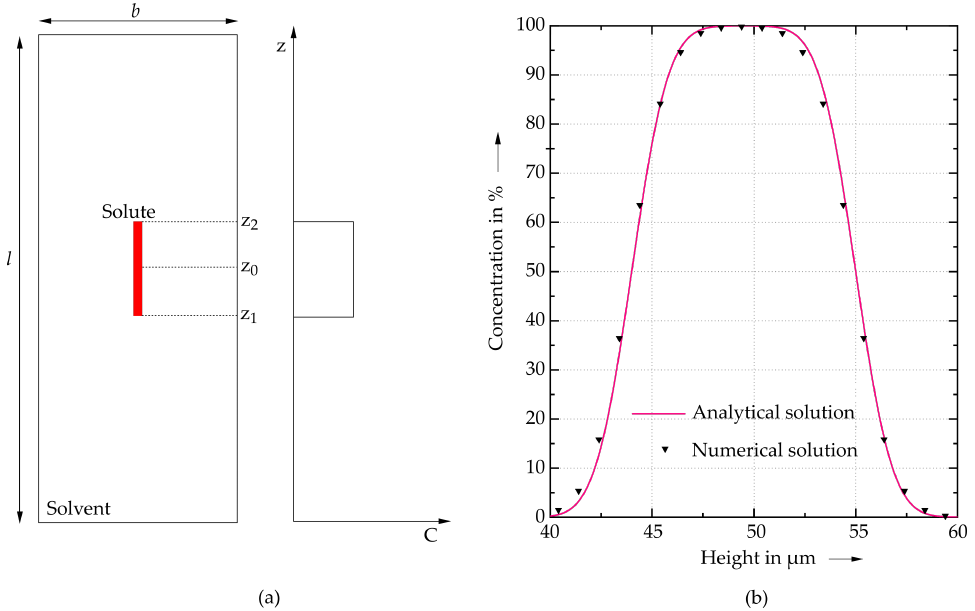
Figure 1. The verification case ( a ) and the comparison of the analytical solution with the numerical solution for t = 1.0 s ( b ). Table 1. Simulation parameters and material properties for the diffusion